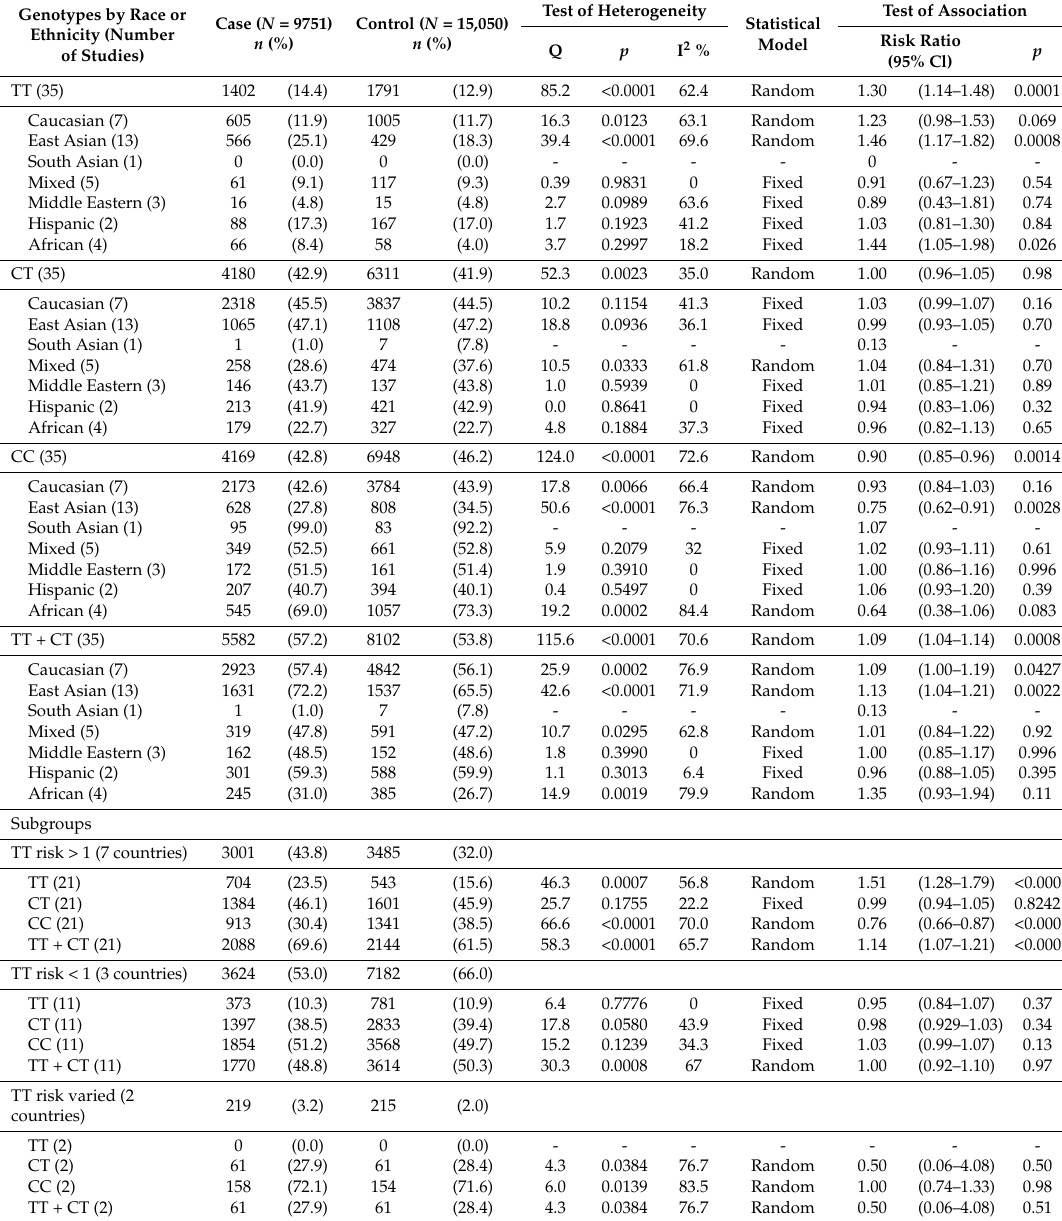
Table 2. Pooled analysis: MTHFR 677 genotypes and risks of congenital heart diseases for children (35